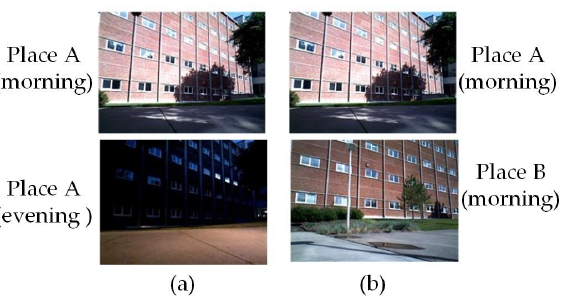
Figure 1. ( a ) Same place with different appearance and ( b ) similar looking different places.